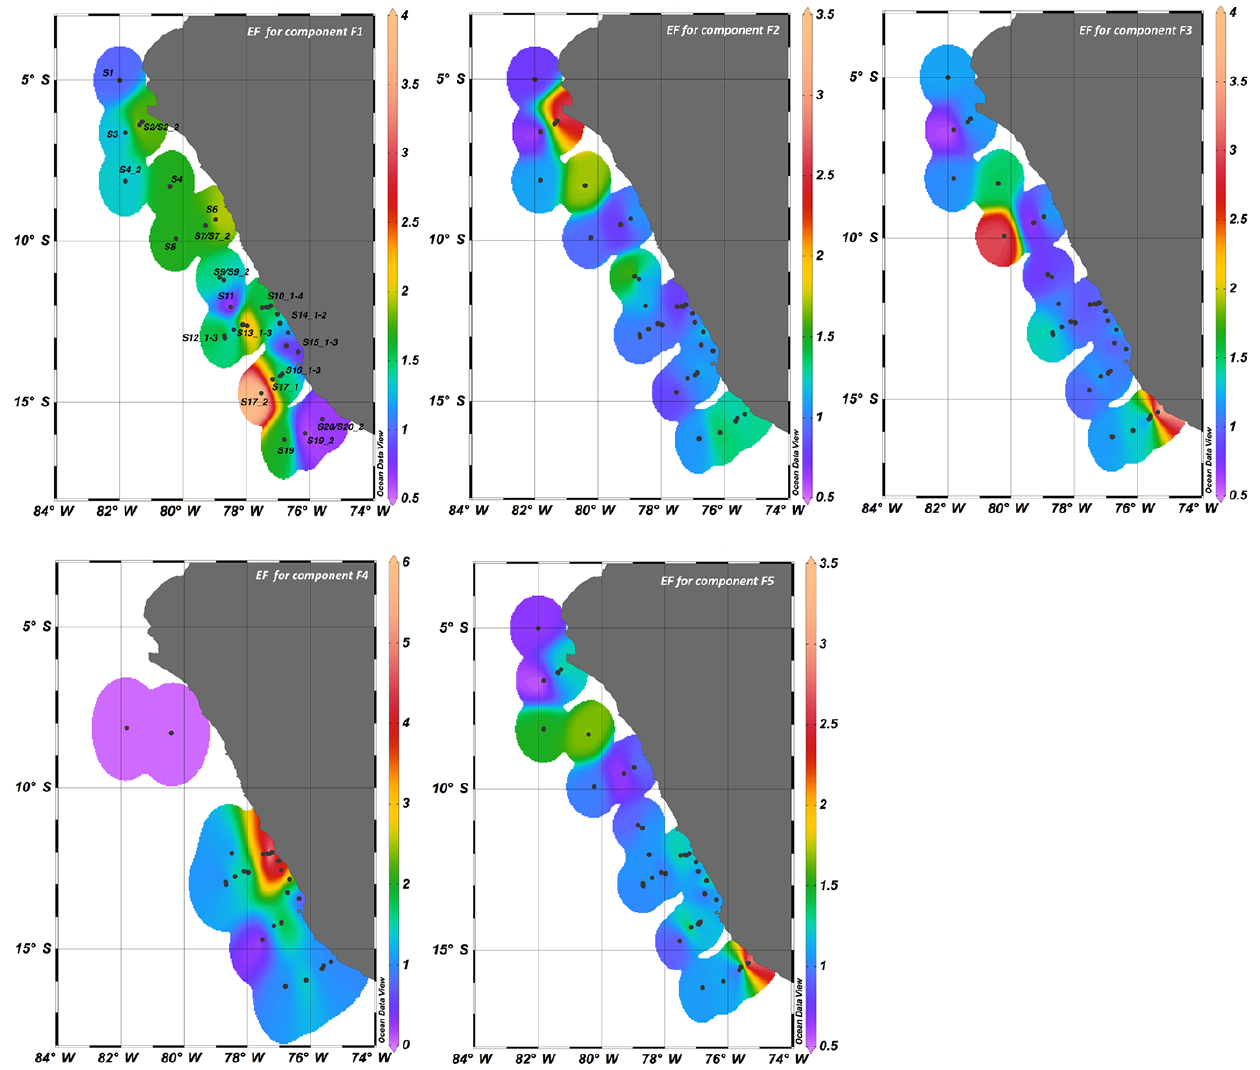
Figure 7. Distribution of enrichment factors (EFs) for fluorescent components F1, F2, F3, F4, F5 identified in this study. Maximum EF for F4 has been recorded at station S10_2, with a value of 14.9. For visualization purposes, this data point is not included in the figure and fluorescence intensities have been scaled down to a maximum EF =